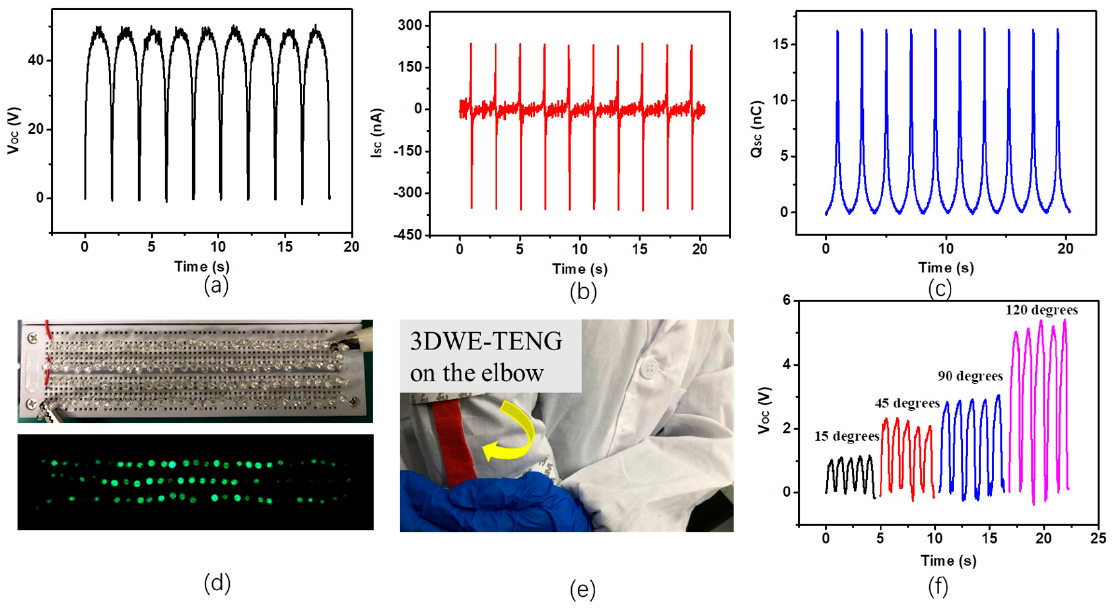
Figure 9. ( a – c ) The Voc, Isc, and Q SC of the 3DWE − TENG when it comes into contact with and separates from the PTFE fabric, ( d ) the 3DWE − TENG can be used to light up 87 LEDs, ( e ) photograph of the 3DWE − TENG as a bend-stretch sensor, ( f ) output voltages of 3DWE − TENG as a bend-stretch sensor at different bend angles (including 15°, 45°, 90°, and 120°).